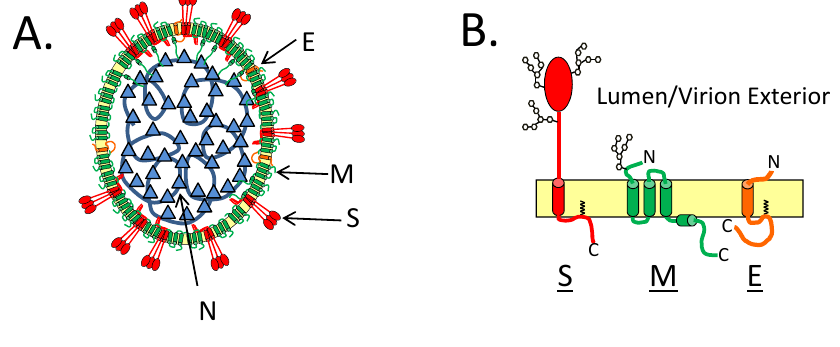
Figure 1. Primary structure of the Coronavirus (CoV) E protein. ( A ) A cartoon depicting a CoV virion. The structural proteins are labeled. ( B ) The three major CoV structural proteins in the virion envelope. Oligosaccharides are shown on S and M. A single topology is shown for E, see below for discussion on E protein topology. ( C ) A multiple